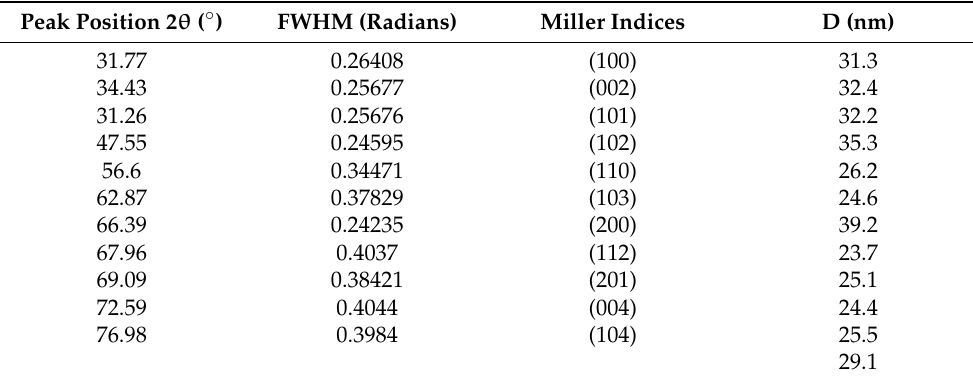
Figure 2. ZnO nanoparticle diffraction pattern using X-ray powder spectroscopy. Table 2. Evaluation of crystal size D from XRD